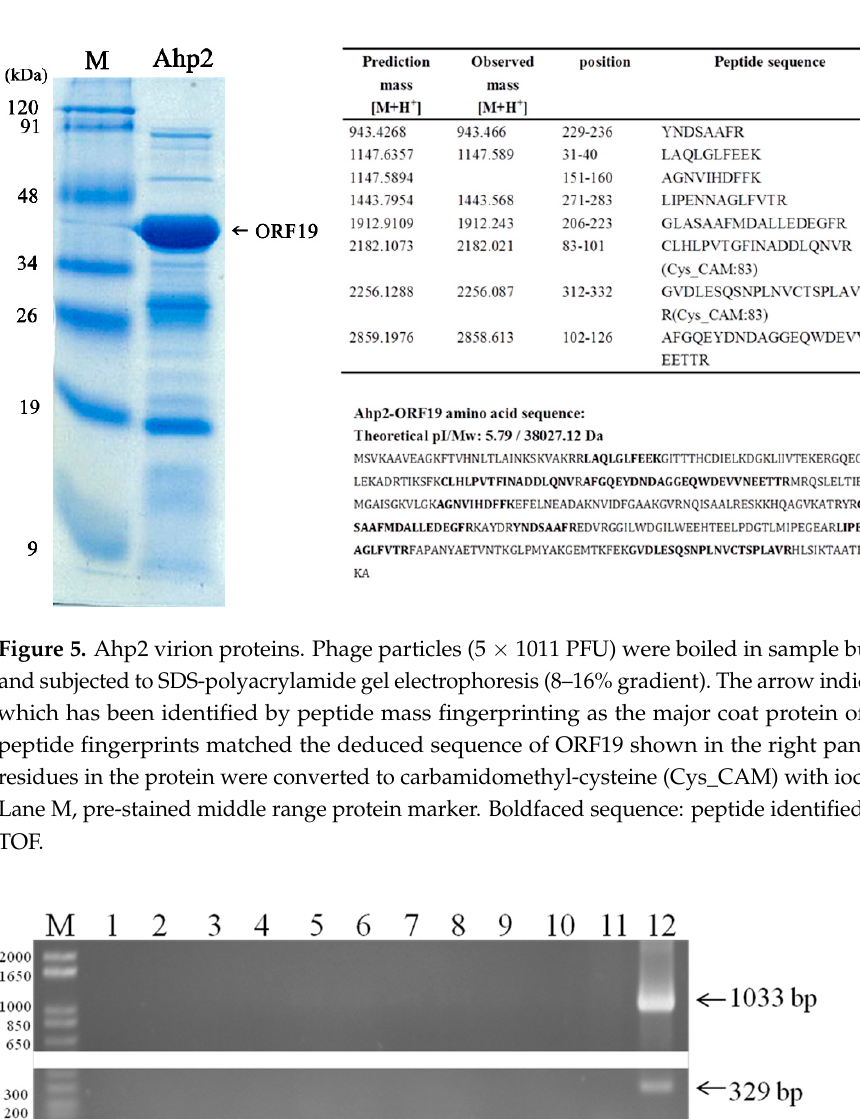
Figure 6. PCR detection of Ahp2 ORF19 and ORF77 in phage-resistant mutants of A. hydrophila AH300206. DNA templates were prepared from 10 Ahp2-resistant mutants of A. hydrophila AH300206 (lanes 1 to 10), A. hydrophila AH300206 (lane 11), and Ahp2 (lane 12) for the amplification of ORF19, PRF77, and 16S rRNA. “M”: molecular size marker (1 kb Plus DNA ladder,